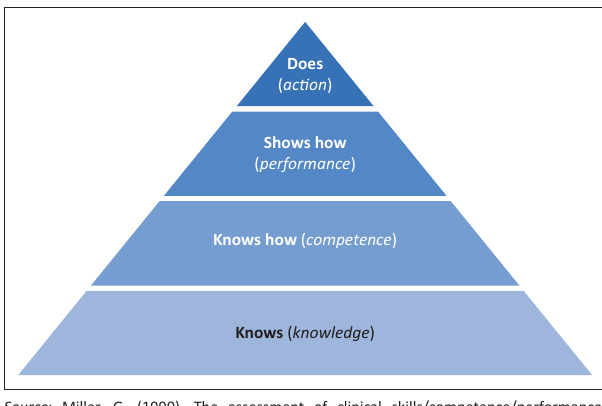
FIGURE 1: Miller’s prism of clinical